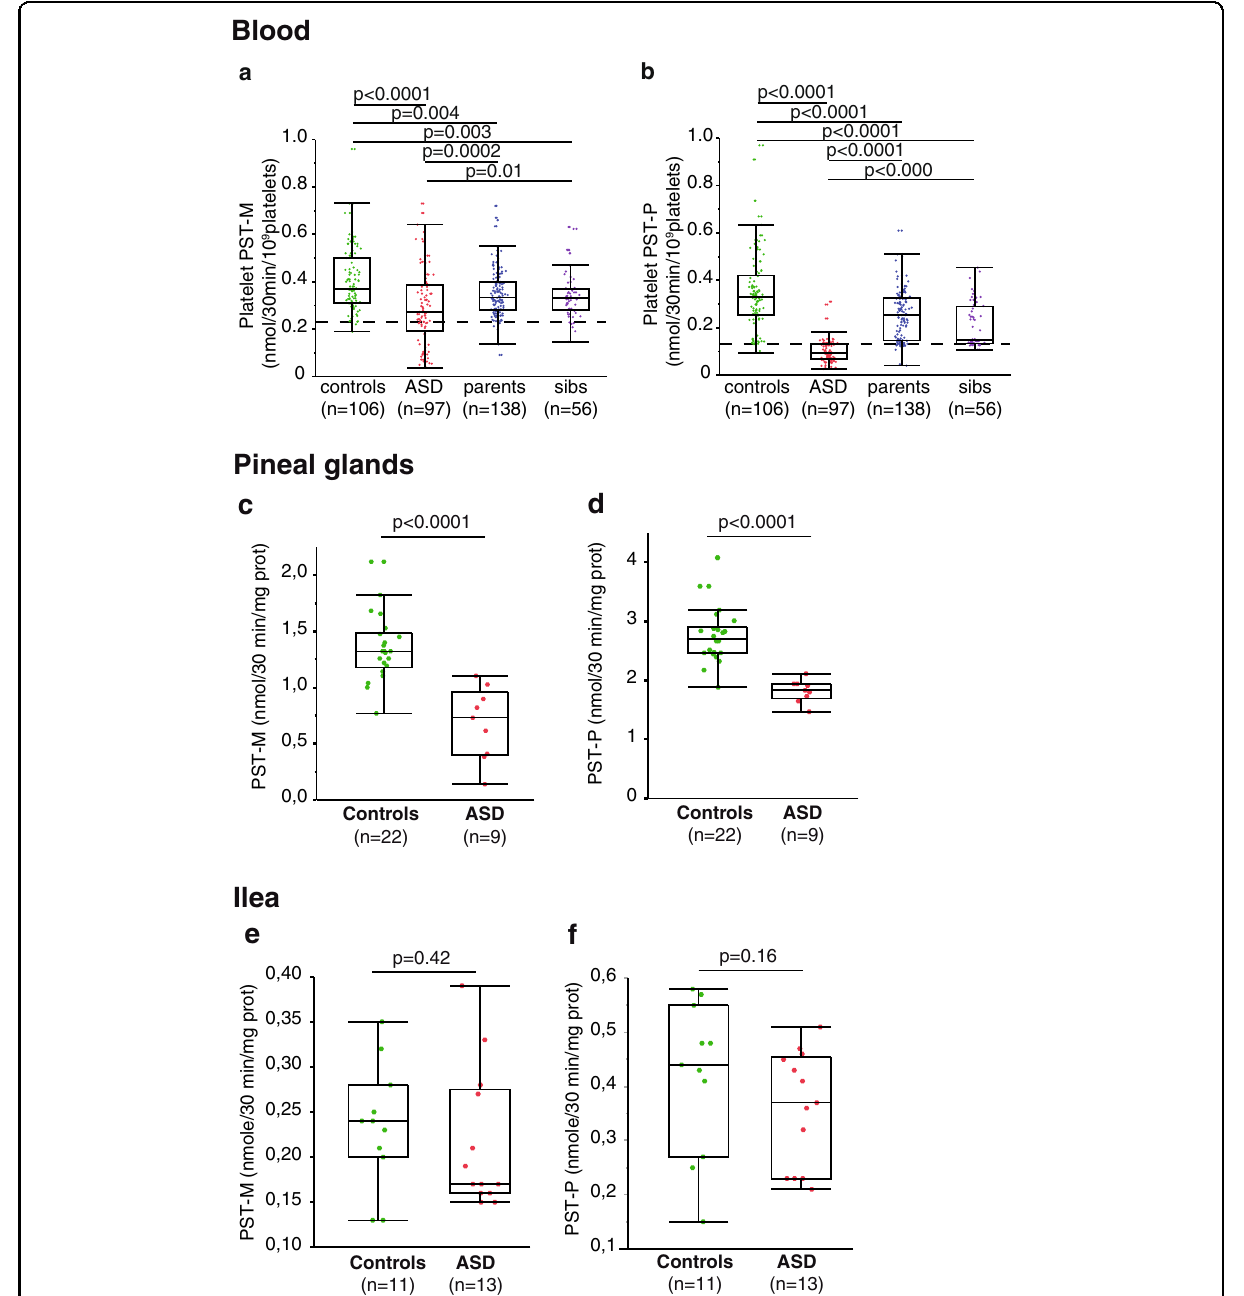
Fig. 2 Phenol sulfotransferase activities in blood, post-mortem pineal glands, and ileal samples from patients with ASD. a – c Blood samples were taken in the morning from 97 unrelated individuals with ASD, their fi rst-degree relatives (138 parents and 56 unaffected sibs), and 106 controls. a Platelet PST-M activities. b Platelet PST-P activities. c , d Pineal gland samples were obtained from 9 patients with ASD and 22 age- and sex-matched controls. e , f Ileal samples were obtained from 13 patients with ASD and 11 matched controls. Boxes indicate medians and quartiles. Dashed lines indicate the threshold of the 5th percentiles of the control group. Groups were compared using the Wilcoxon two-sample